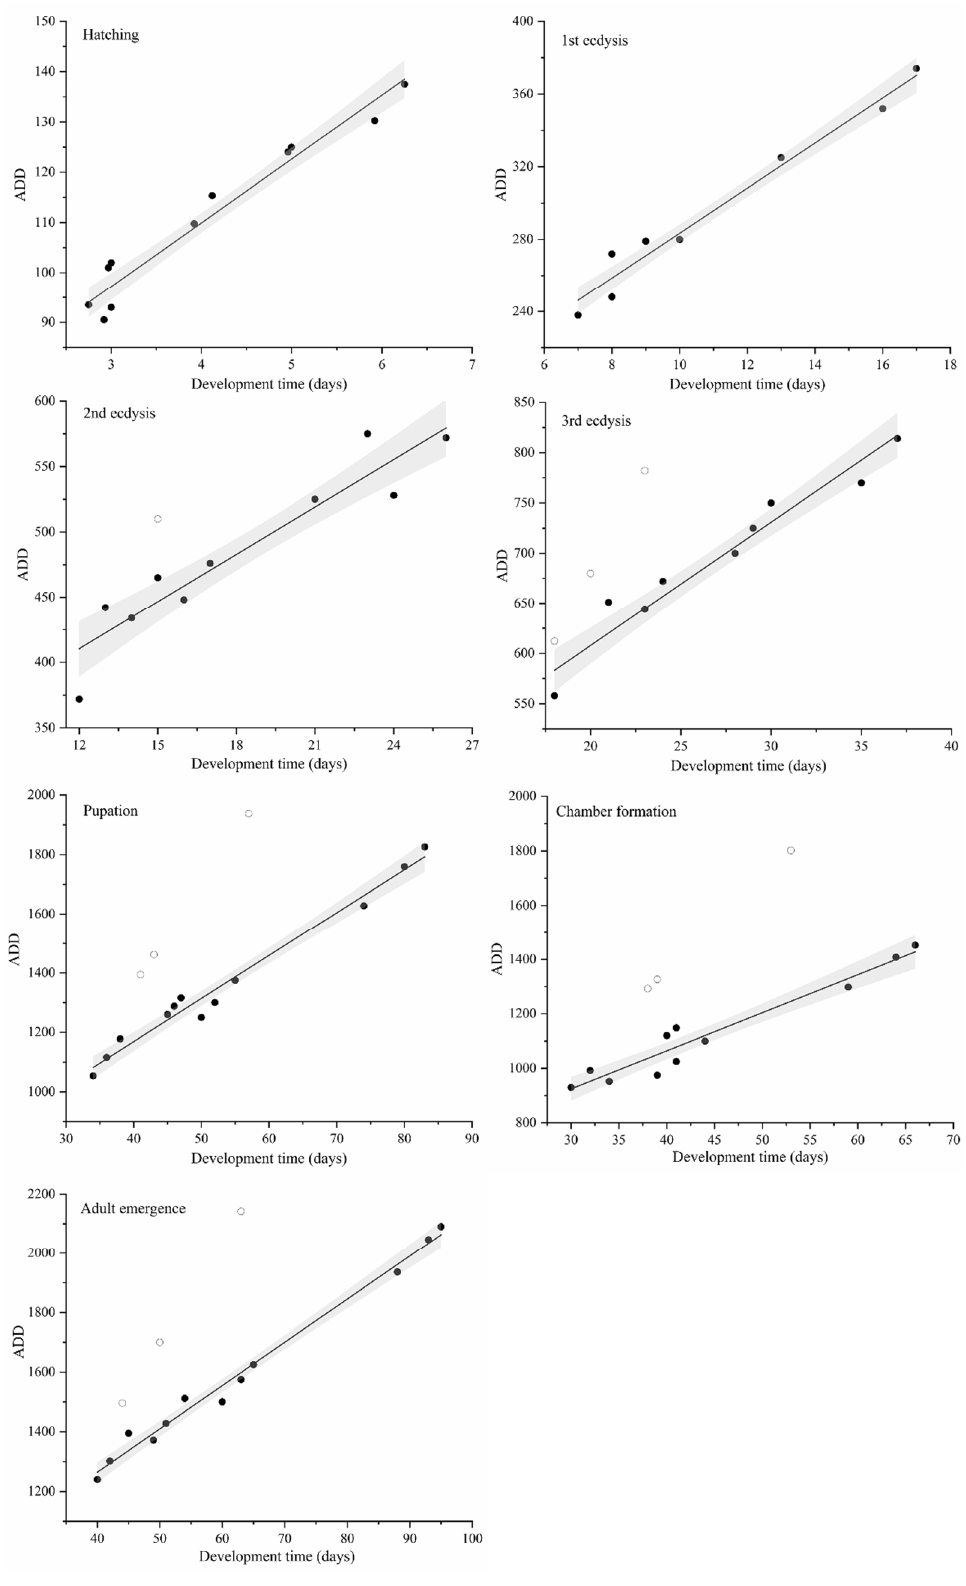
Figure 3. Thermal summation models of different development stages of Necrobia ruficollis. ● repre- sents the data used in the regression analysis, while ○ represents the eliminated data. The solid line represents the regression line. The gray area represents the 95% confidence interval.